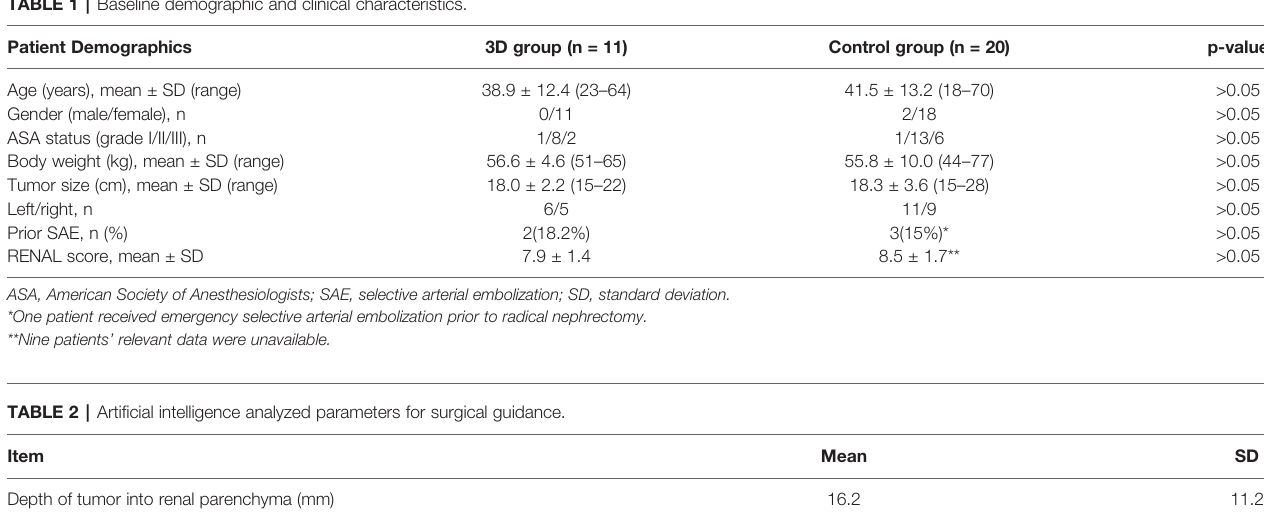
TABLE 2 | Arti fi cial intelligence analyzed parameters for surgical guidance. Item Depth of tumor into renal parenchyma (mm)